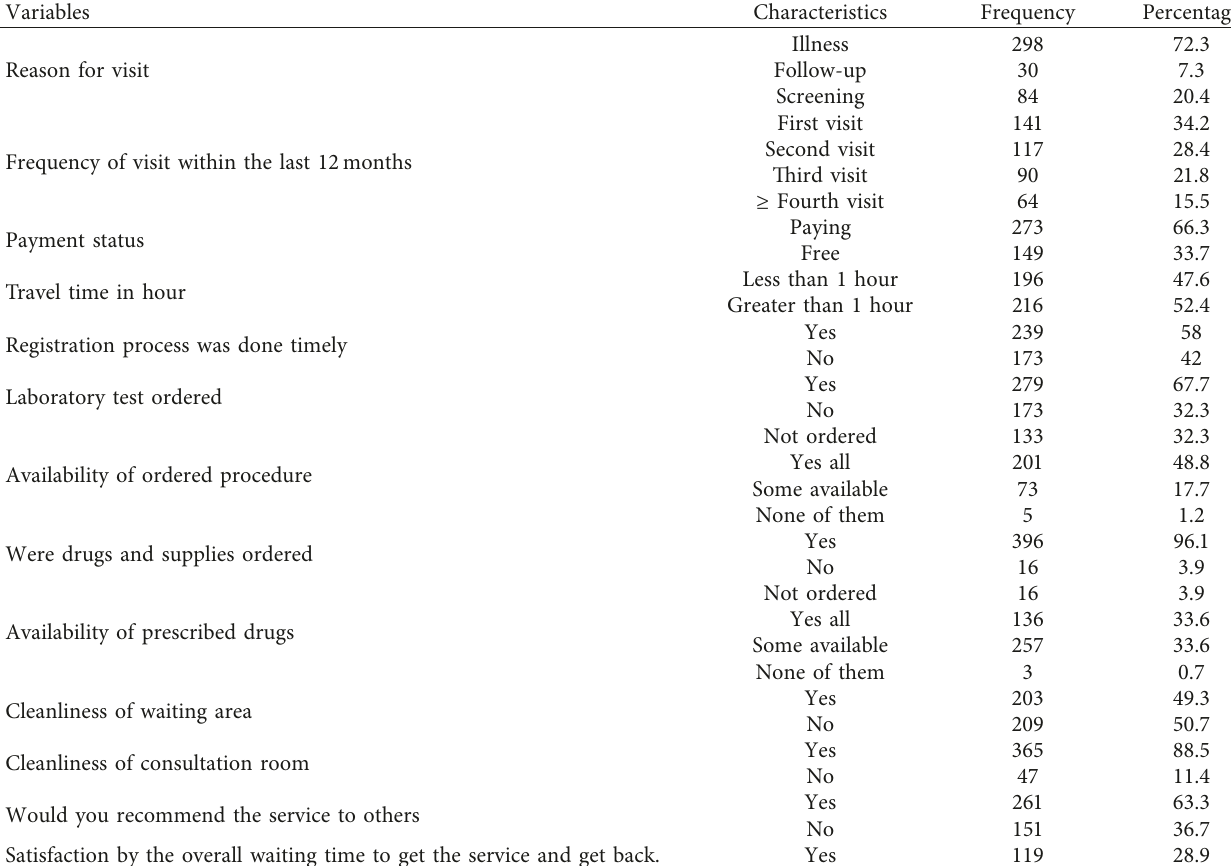
Table 2: Institutional aspects and patterns of visit among clients in the outpatient department of DURH, Ethiopia, 2021 ( n � 412). Variables